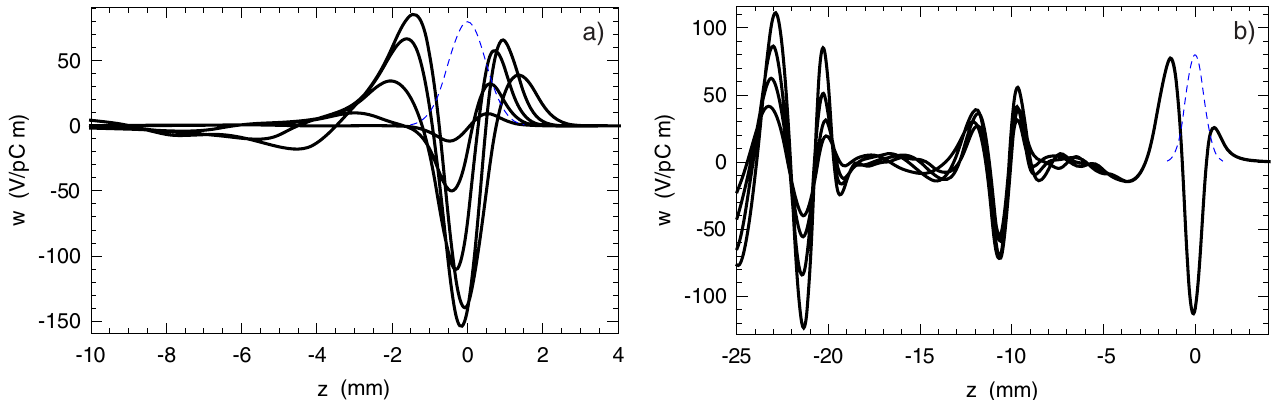
FIG. 6. (Color) Wakefields for the case A ¼ 3 and b ¼ 2 cm at various distances from the entrance to the toroid: (a) distances 4, 8, 12, and 16 cm from the entrance (a larger distance corresponds to a larger amplitude of the wake), (b) distances 84, 88, 92, and 96 cm from the